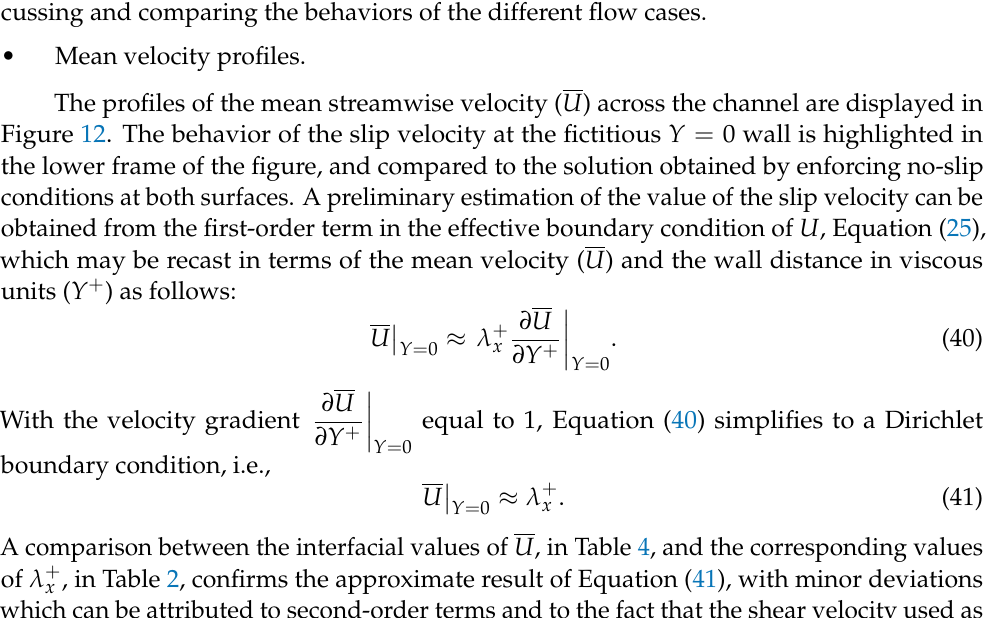
Table 3. Values of the total shear stress ratio between the lower and the upper walls ( S R = the percentage change in the skin-friction drag coefficient ( ∆ C f %).